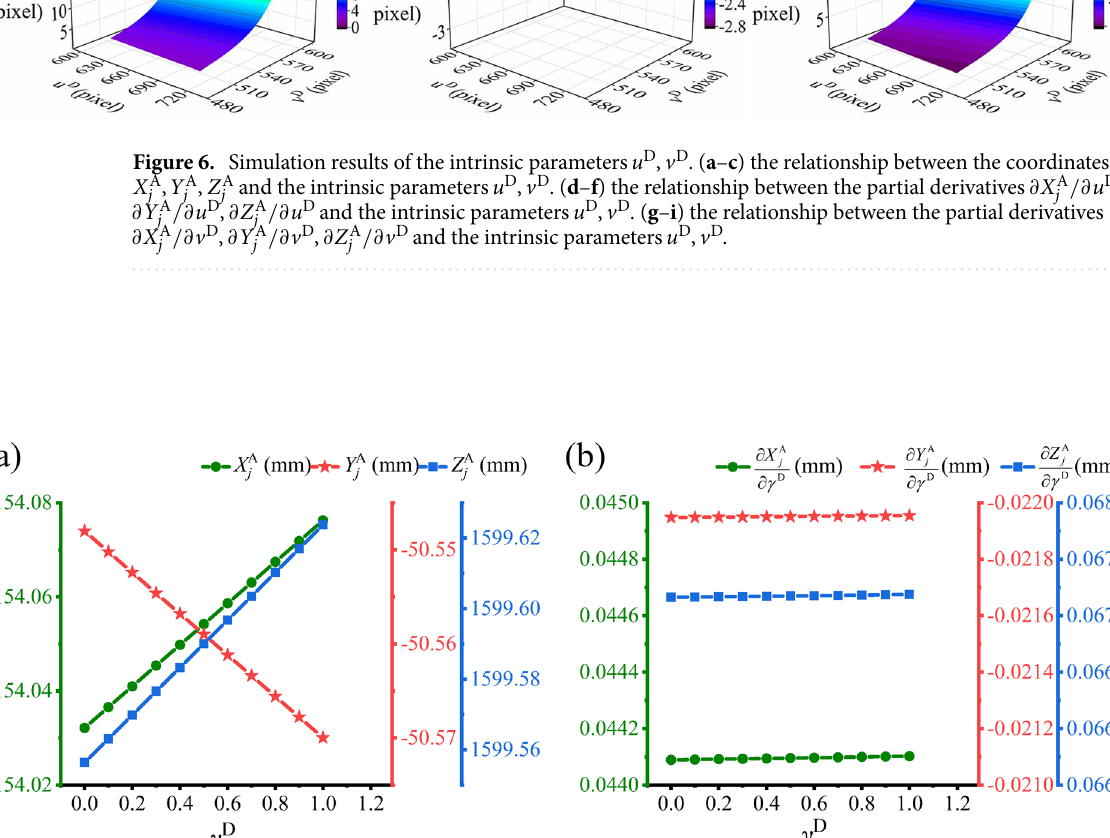
γ D . ( b ) The relationship between the partial derivatives ∂ X A